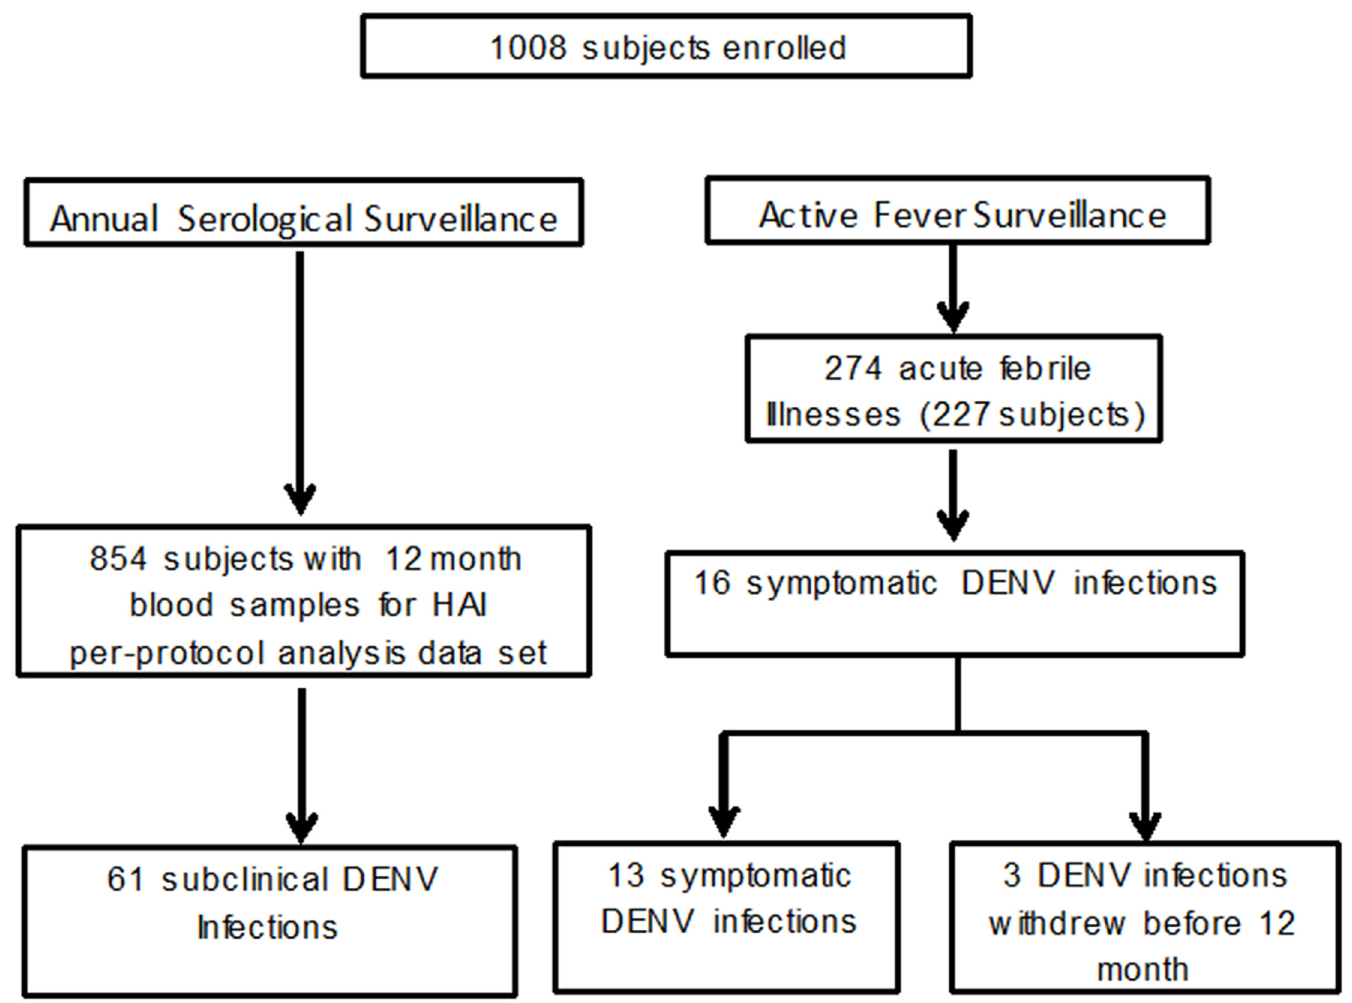
Fig 1. Study flow